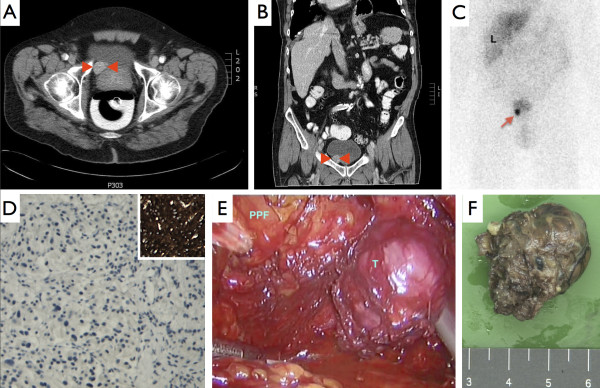
Abdominal computed tomography, 123I-MIBG scintigraphy, pathology and preperitoneal endoscopic resection of the pheochromocytoma. Axial (A) and coronal view (B) on abdominal computed tomography with intravenous and rectal contrast shows a round-shaped, sharply demarcated tumour of 1.7 by 2.5 cm possibly attached to the bladder wall just lateral to the prostate. No local (or distant) lymphadenopathy was observed. Arrowheads in red indicate the tumour. The iodine-123-metaiodobenzylguanidine (123I-MIBG) SPECT-scan shows high uptake of 123I in the periprostatic tumour without suspicion of catecholamine-producing tumours located elsewhere in the body (C). Furthermore, aspecific uptake can be observed in the liver and also the bladder through renal clearance of the (coupled) isotope. “R” indicates the right side of the patient and “L” indicates the liver. The red arrow indicates the tumour uptake of 123I-MIBG. Hematoxylin staining of the transrectal biopsies of the tumour showed epithelial cells with dark nuclei that differed in size with local tube formation (D). In the cytoplasm of the epithelial cells, a granular pattern was observed. Immunohistochemistry of the tissue shows a positive staining for chromogranin A, CD56 and synaptofysin. Staining for PSA and PSAP, which might be indicative of prostatic tissue, were negative. The inlet illustrates the chromogranin A immunostaining on the tumour tissue. Snapshot of the camera during preperitoneal endoscopic resection of the paraganglioma shows the close proximity to the prostate (E). The peri-prostatic fat is indicated in light-blue by “PPF” and the tumour by “T”. Gross macroscopy of the 3.5 by 2.5 by 2 cm partly encapsulated tumour that was resected via preperitoneal endoscopic surgery (F).